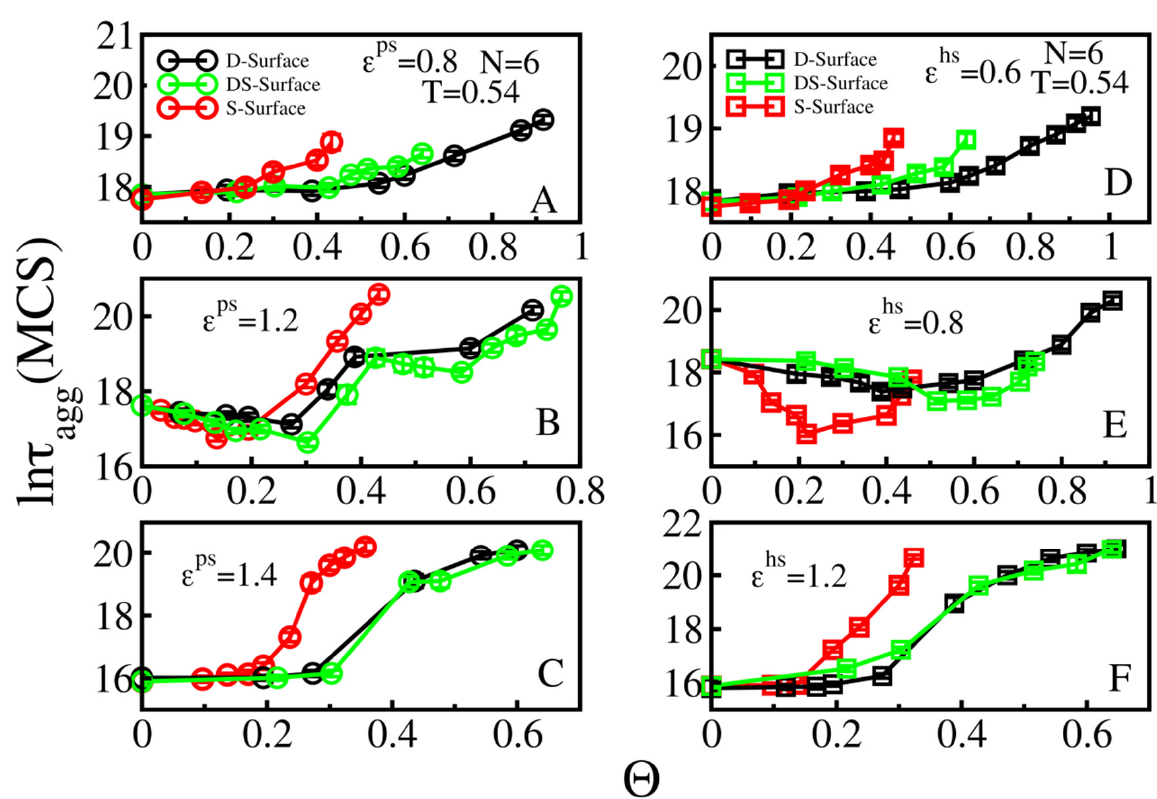
Figure 6. Dependence of ln τ agg on Θ for N = 6 chains at T = 0.54. Red, green and black circles refer to the S-, DS-, D-surfaces, respectively. Results are shown for the weakly ε ps = 0.8 ( A ), medium ε ps = 1.2 ( B ), strongly ε ps = 1.4 ( C ) absorbing hydrophilic surfaces, as well as for weak ε hs = 0.6 ( D ), medium ε hs = 0.8 ( E ) and strong ε hs = 1.2. ( F ) regimes of attractive hydrophobic surfaces. Error bars are lower than data symbols.